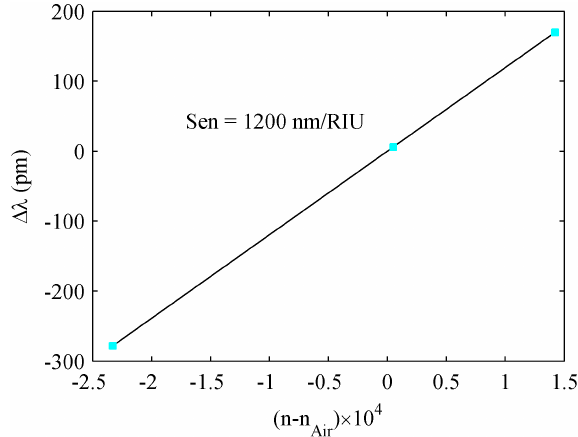
Figure 11. Transmission and spectral position of the cavity mode for the 1-D photonic crystal nanocavity with linearly changing air layer thickness as shown in Fig. 10. The mode has a very narrow bandwidth, yielding a sensor with good resolution.